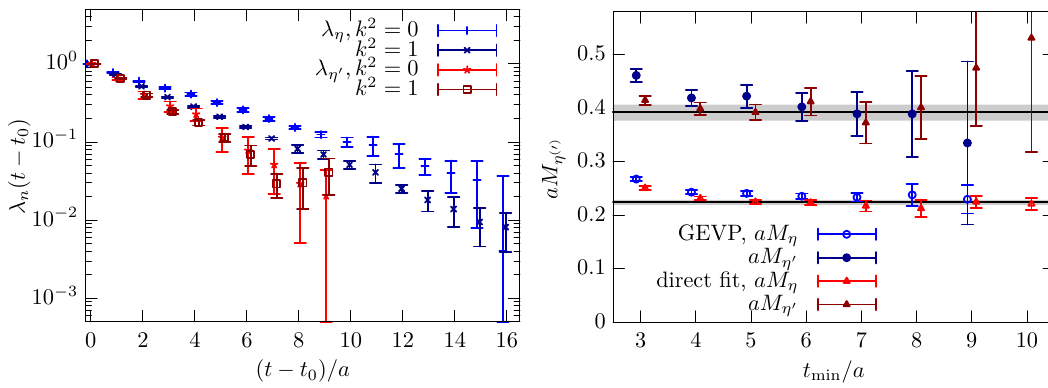
Figure 4. (Left) The η and η 0 eigenvalue functions for two momenta, a 2 ~k 2 = 0 and a 2 ~k 2 = 1 determined on ensemble H105, obtained by solving the GEVP, with the reference time slice t 0 = 5 a . For better visibility, some points are shifted slightly and the data for the η 0 are omitted for ( t − t 0 ) /a ≥ 10 due to the large errors. (Right) Results for the masses determined by fitting to the lowest two eigenvalues of the GEVP and from direct fits (eqs. (4.9) and (4.15)) as functions of the starting point of the fit, t min . The analysis is similar in both cases, employing the same basis of interpolators and incorporating data at two momenta. The horizontal lines and grey error bands indicate the final results. These have been obtained from a slightly different fit, employing different t min for different elements of the correlation matrix. For the GEVP results, t 0 /a = t min /a − 1